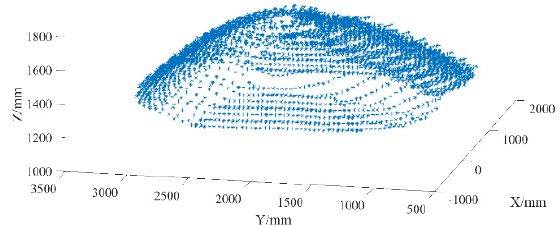
Figure 25. Distribution of points at the ends of the UR5 robot’s joints.